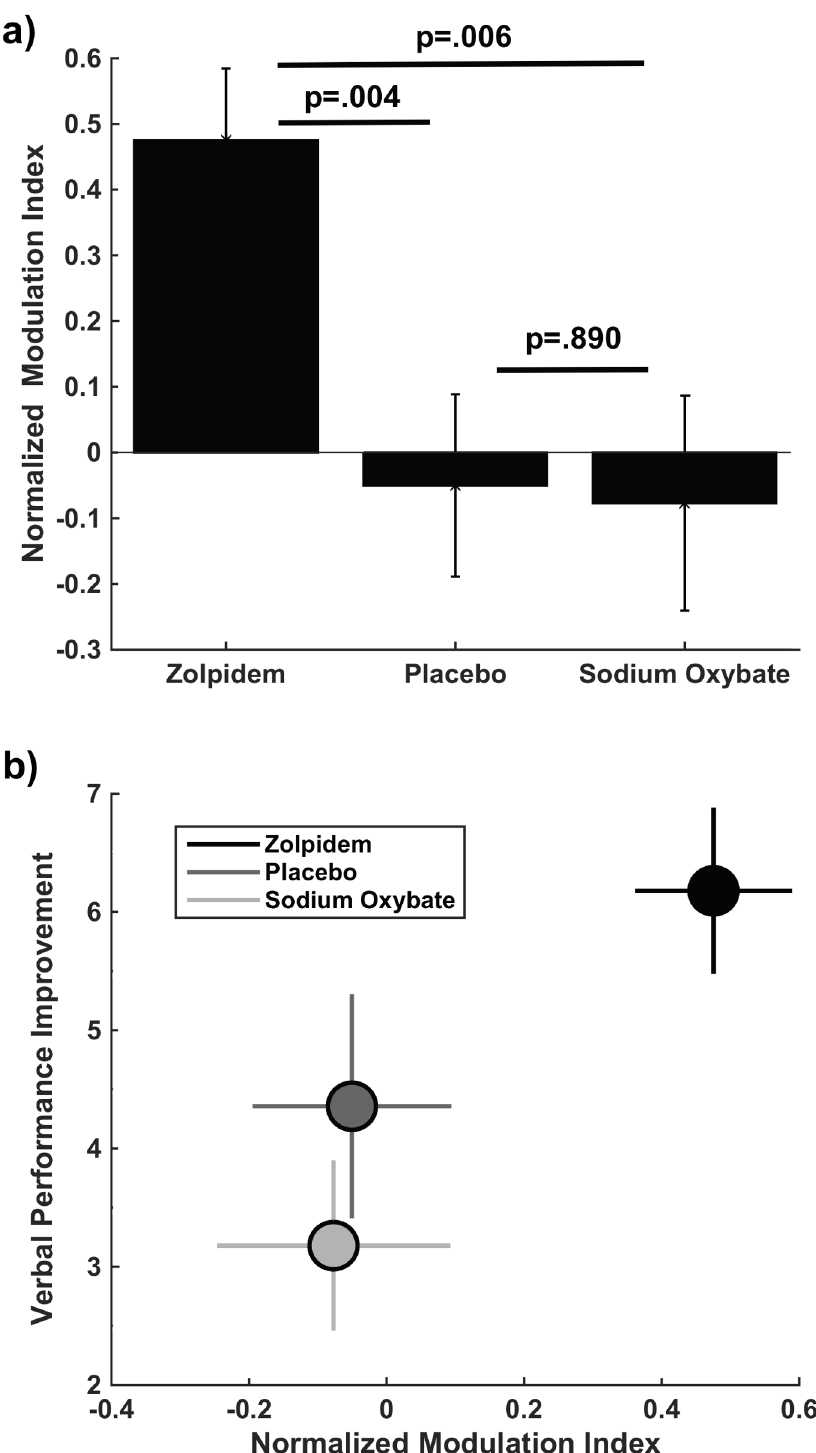
Fig 4. (a): Normalized modulation index for spindle/SO complexes. (b): Normalized modulation index and memory performance improvement: Modulation Index in each drug condition (zolpidem (black circle), placebo (dark grey), sodium oxybate (light grey) are shown relative to change scores in verbal